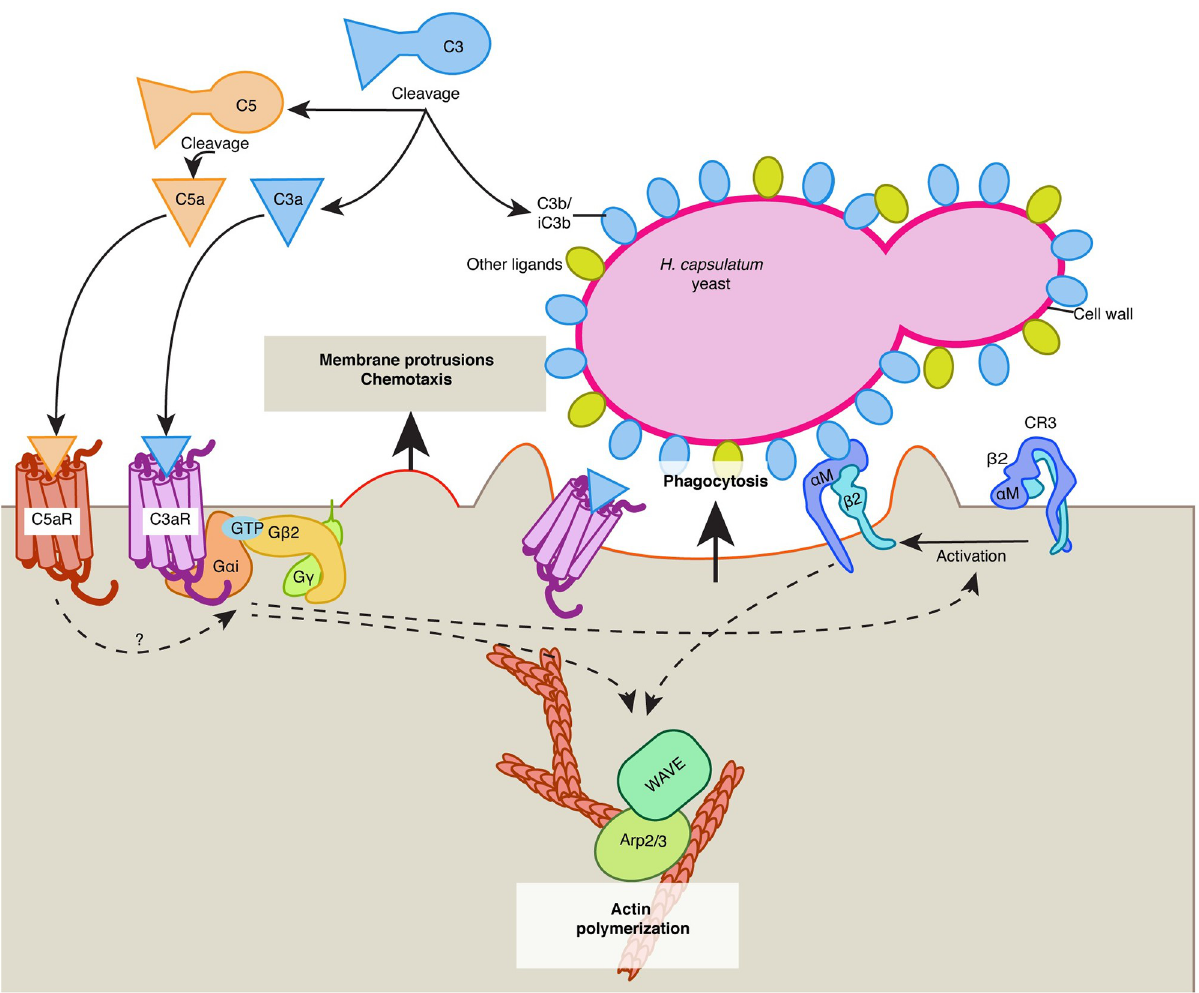
Fig 8. Model for the role of complement and C3aR in macrophage recognition of Hc yeast. We propose the following model for the role of complement and C3aR in macrophage recognition of Hc : C3, derived from serum, reacts with the Hc cell-wall, leading to C3b/iC3b deposition on the cell-wall, and release of C3a, which diffuses away from the yeast surface leading to a concentration gradient emanating from the yeast cell-wall. C3a activates C3aR, which signals through G α i and G β 2 to promote the formation and directional movement of actin-rich membrane protrusions, and possibly to promote local activation or increased motility of the integrin receptor CR3. Active CR3 can then recognize C3b/iC3b or other features of the Hc cell-wall. C3aR and/or CR3 activation then coordinates actin polymerization and phagocytic cup formation by regulating the activity of actin polymerization regulators Arp2/3 and SCAR/WAVE. In the presence of C5-containing serum, the C5 convertase can similarly catalyze the cleavage of C5 at the fungal surface, leading to release of C5a and activation of C5aR, which may also drive local chemotaxis and activation of phagocytic integrins to promote phagocytosis.